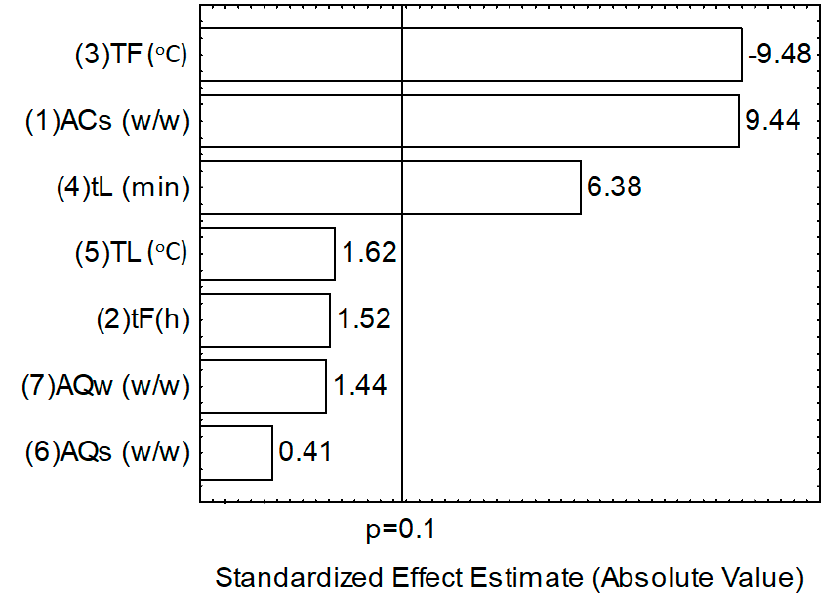
Figure 8. E ff ect of the process variables on Fe extraction (%Fe)—screening experiments ( p = Figure 8. Effect of the process variables on Fe extraction (%Fe)—screening experiments (p = 0.1–90%